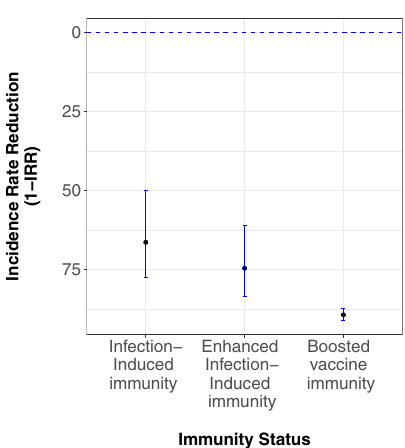
Fig. 2 Reduction in incidence rate of COVID-19-related hospitalization compared to non-recent vaccine immunity (dashed blue line at x =